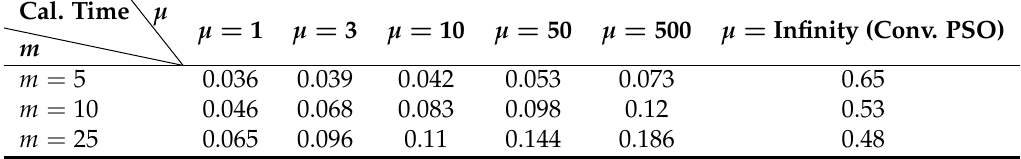
Table 2. Average calculating time with different µ and m where w = 0.6, p = 8, q = 2, N = 100, SNR = 5 dB, RMSE = 0.26.